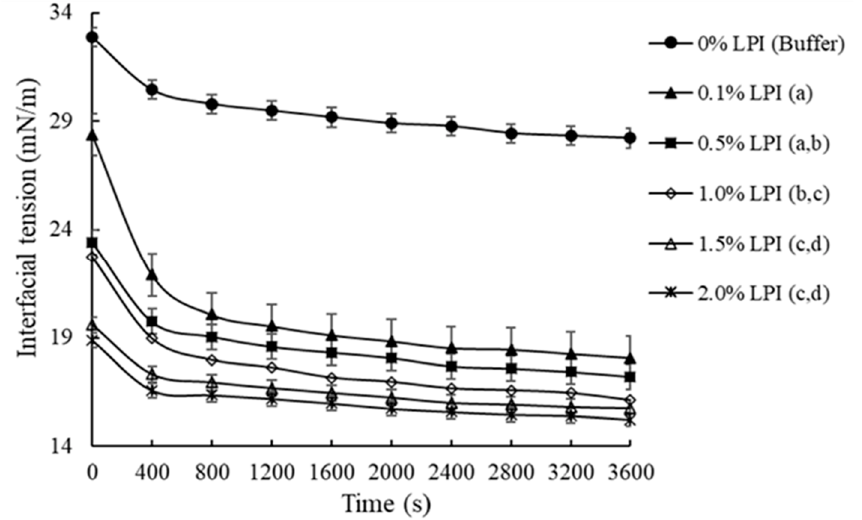
Figure 1. Interfacial Tension (IT) at oil/water interface containing different concentrations of lupin protein isolate (LPI). Different letters imply relevant differences ( p < 0.05) in the LPI content.